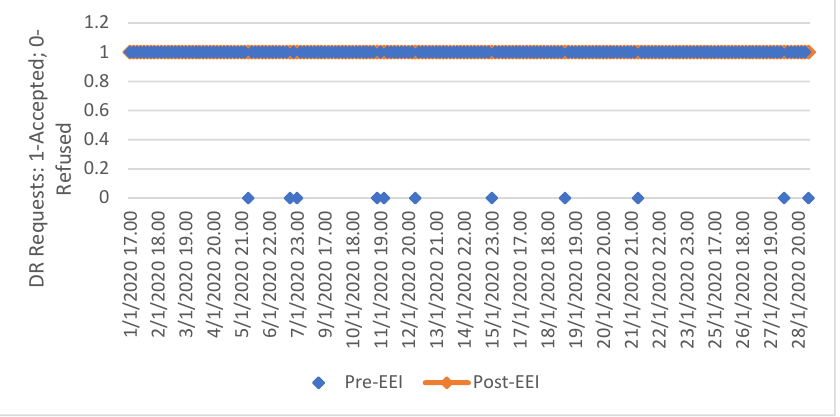
Figure 4. Comparison of pre- and postintervention (heat pump and external coat): 1, accepted DR requests; 2, refused DR requests.